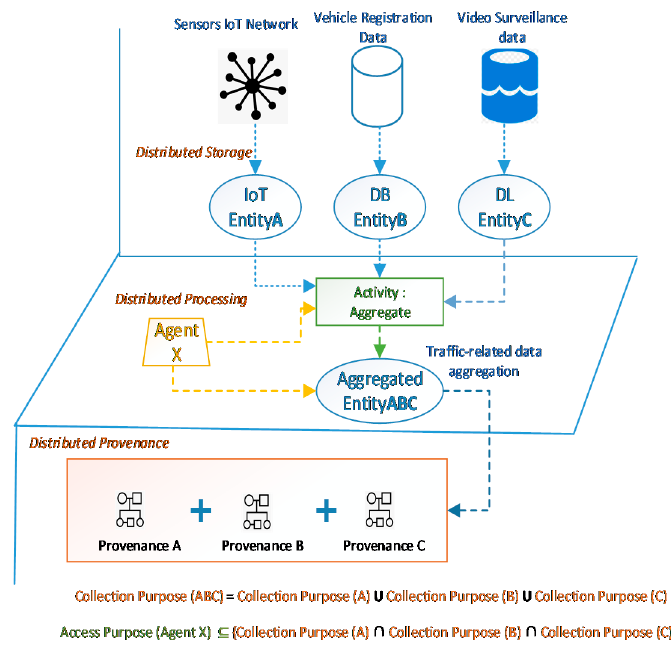
Figure 3. Provenance preservation in aggregated